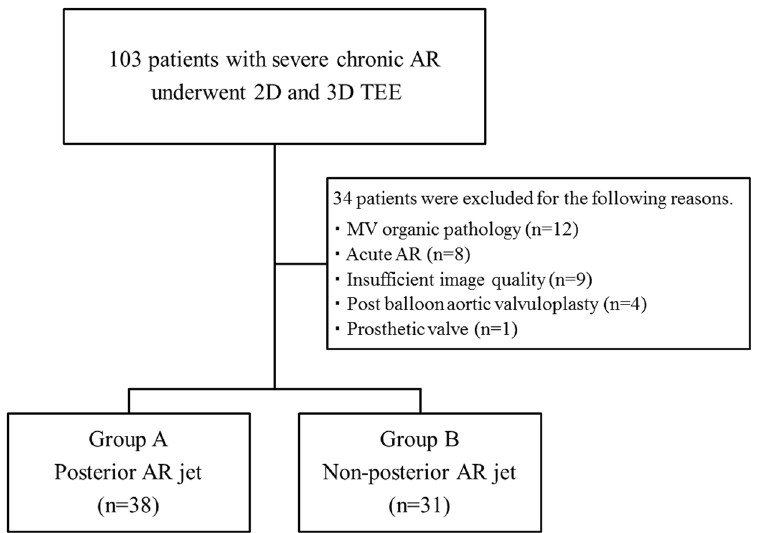
Figure 1. Description of study design. Patients with severe aortic regurgitation (AR) were enrolled and classified based on AR jet direction into the following two groups: posterior jet group and non-posterior jet group.